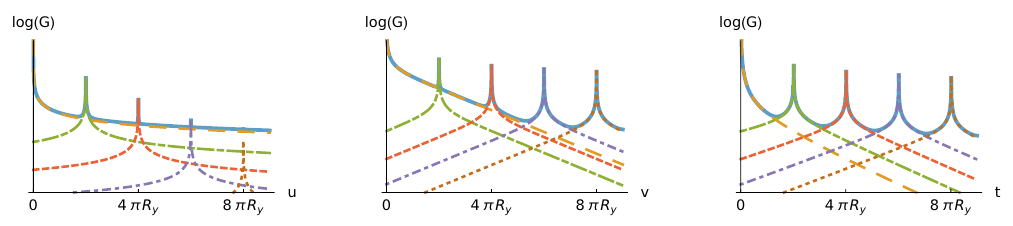
= π/ 8 along Figure 11: Logarithmic plot of the two-point function (6.4) with r H R y three different directions ( u , v and t ) while keeping the orthogonal direction ( v , u / 20. The total value of the two-point function is and y , resp.) constant, here: R y plotted (fat, blue) as well as the individual contributions from the m = { 0,1,2,3,4 } modes (increasingly finely dashed lines). In the u direction, the behavior remains dominated by the m = 0 mode. The other modes appear briefly as poles on the light- cone. The behavior in the v direction is drastically different. Starting at v of order the inverse temperature, the m = 0 mode loses dominance to the “nearest” mode. The behavior it t shares properties of both u and v . The fall-off is exponential between the poles, but the exchange of dominance between the modes makes the long time behavior